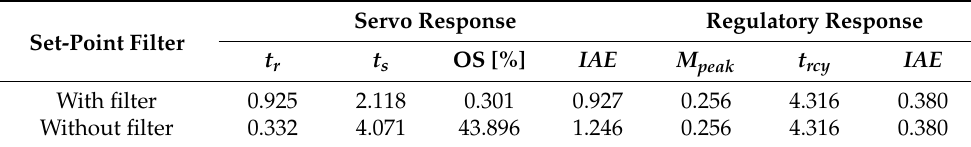
Table 10. Effect of set-point filter for nominal process P 1 .